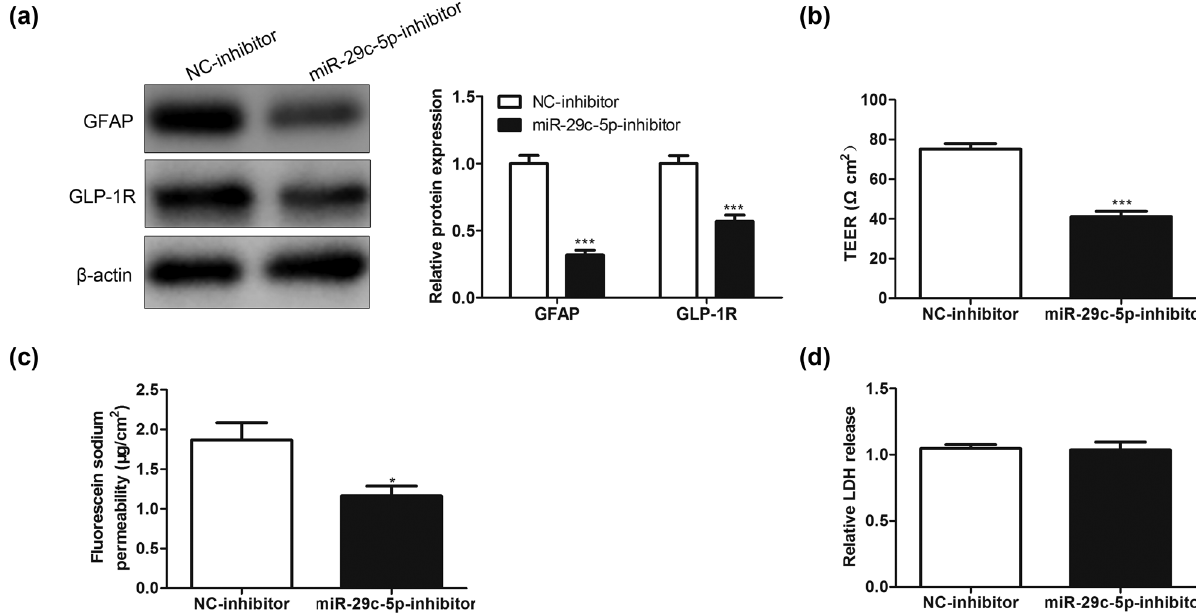
Figure 2: E ff ect of miR - 29c - 5p on the high permeability of BMECs caused by OGD - treated astrocytes. Astrocytes transfected with miR - 29c - 5p inhibitor or NC - inhibitor were treated with OGD for 3h and then cocultured with BMECs for 24h. ( a ) Western blot was performed to analyze the protein levels of astrocyte activation markers GFAP and GLP - 1R. ( b ) Analysis of the TEER value of BMECs. ( c ) Detection of the ability of NaF to penetrate BMECs. ( d ) LDH release assay was performed to assess the injury of BMECs. NC: negative control, GLP - 1R: glucagon - like peptide - 1 receptor, and LDH: lactate dehydrogenase. Data are presented as an average of three independent assays. * P < 0.05, *** P < 0.001 vs NC -